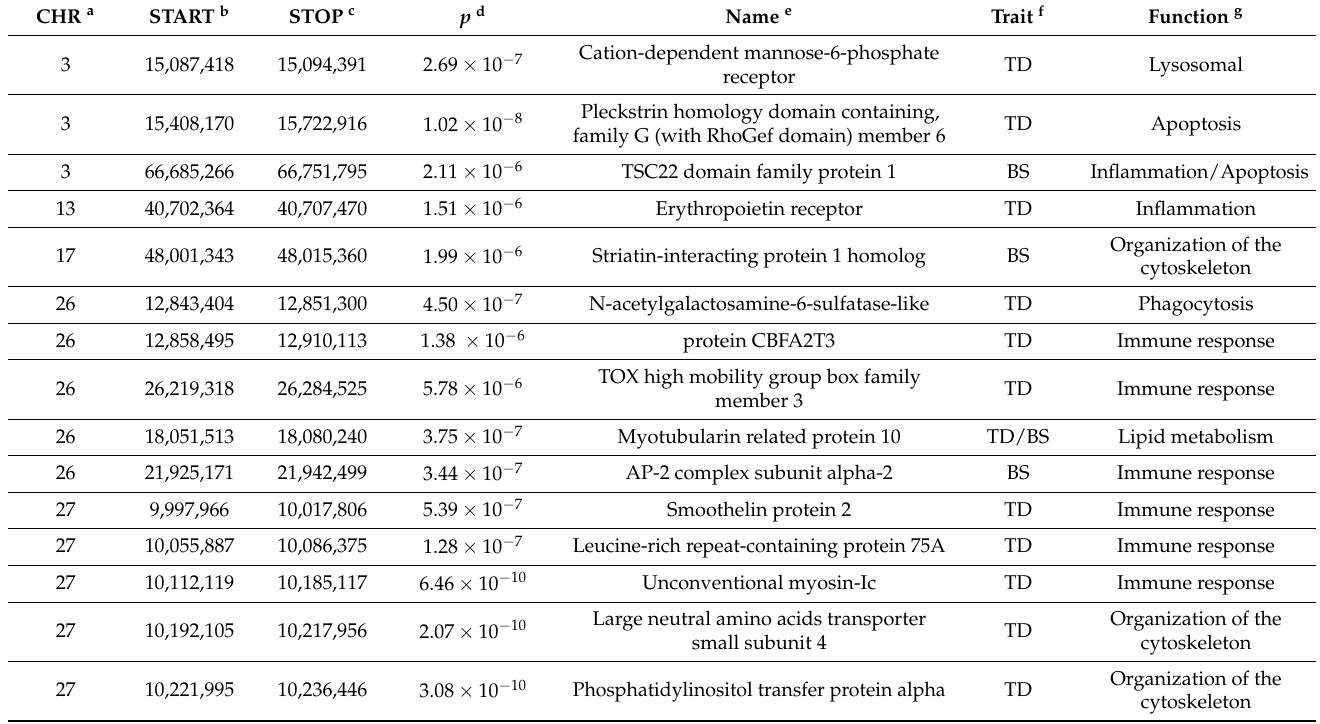
Table 3. Results of the gene-based analysis using MAGMA: Candidate genes related to resistance to P. salmonis in rainbow trout for time of death (TD) and binary survival (BS) traits.